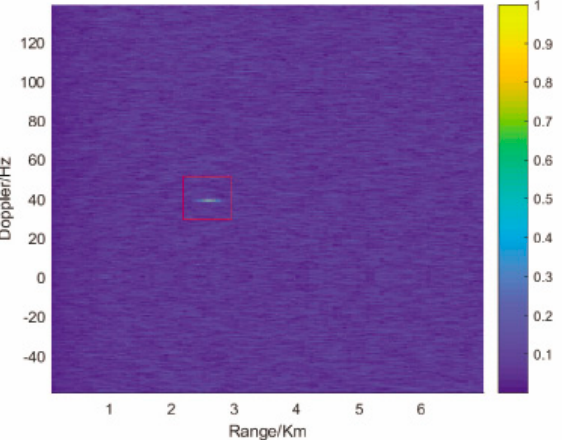
Figure 15. Coherent processing results based on the proposed method.